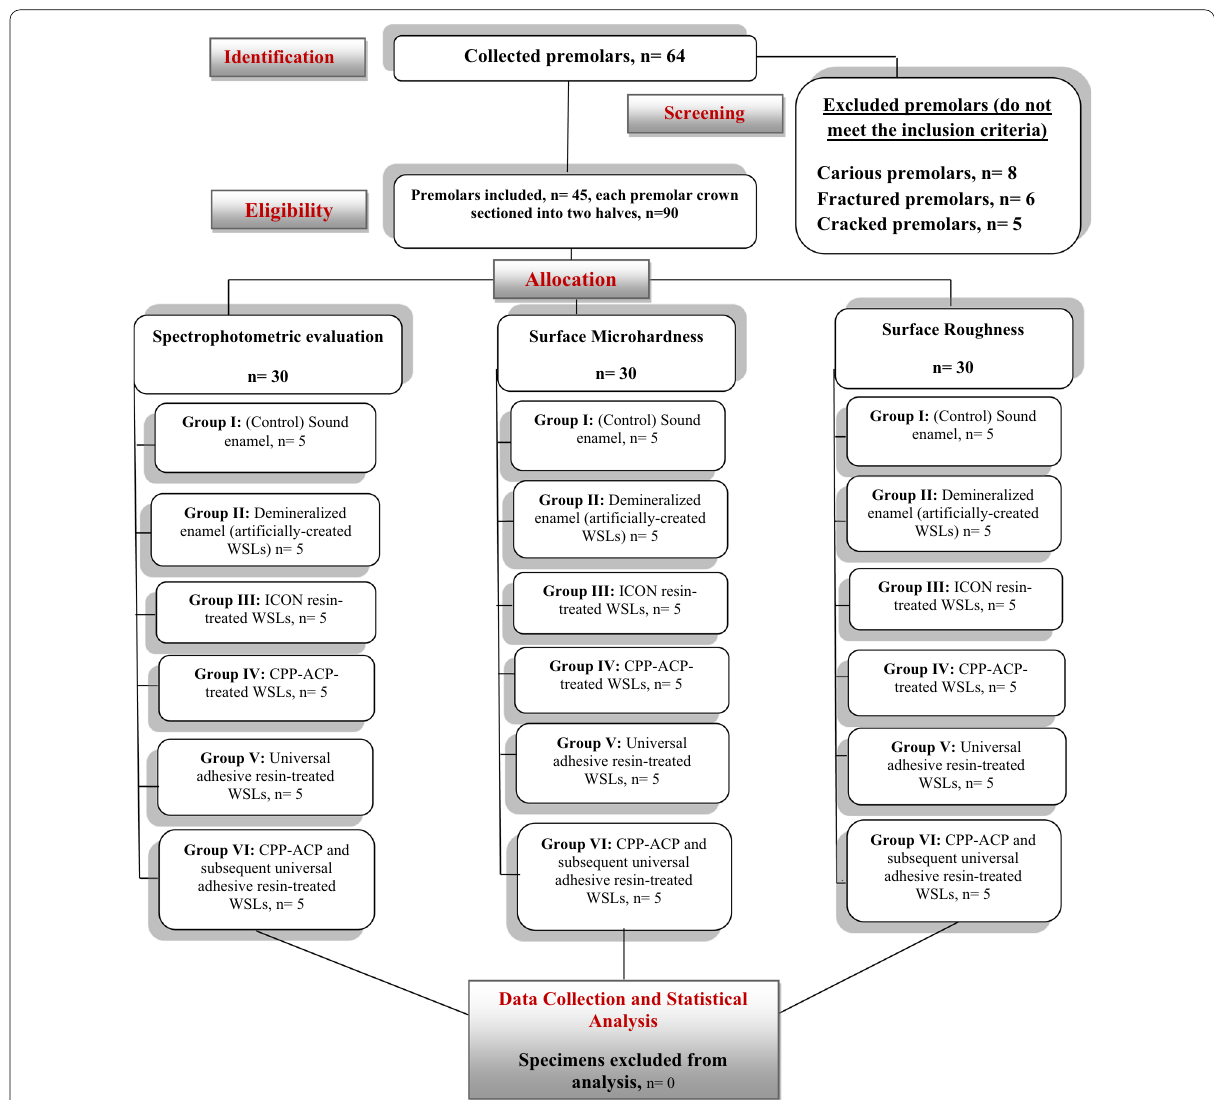
Fig. 1 Consort flow